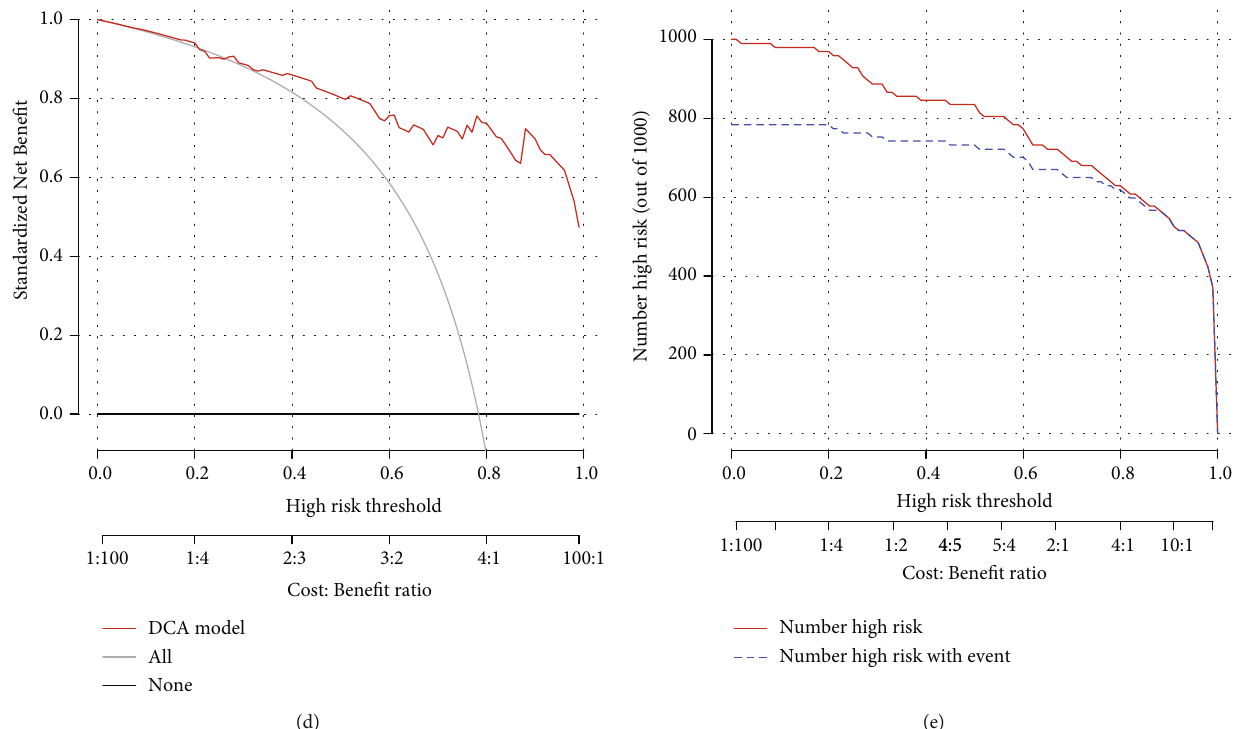
Figure 2: E ffi ciency and validation of the disease diagnosis model. (a) ROC of diagnosis model in di ff erentiating SLE patients from healthy controls. (b) Calibration curve of the diagnosis model. (c) Nomogram based on the diagnosis model. (d) Decision curve for the diagnosis model in predicting SLE. Standard net bene fi t ( y -axis) and risk threshold ( x -axis) formed the coordinate system. The red line represented our model, grey line represented the assumption that all the people were su ff ering SLE, and black line represented the assumption that all the people were healthy. (e) Clinical impact curve analysis diagram. Red line represented number of people which were diagnosed with SLE by our model at di ff erent threshold probability, and blue line represented number of SLE patients.